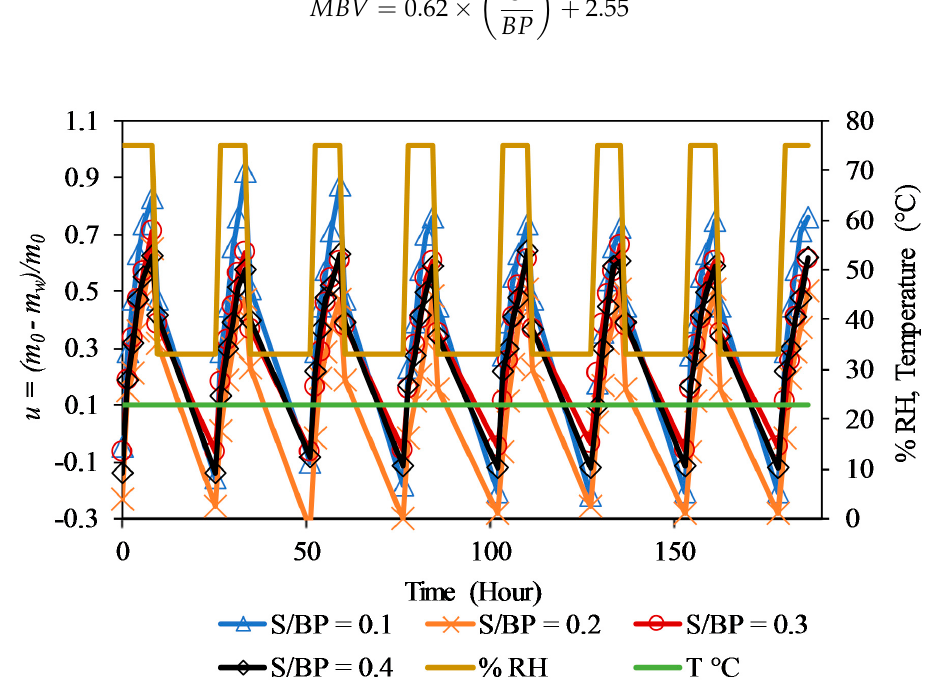
Figure 15. Moisture uptake and release of S-BP concrete during cyclic relative humidity variation in climatic chamber.